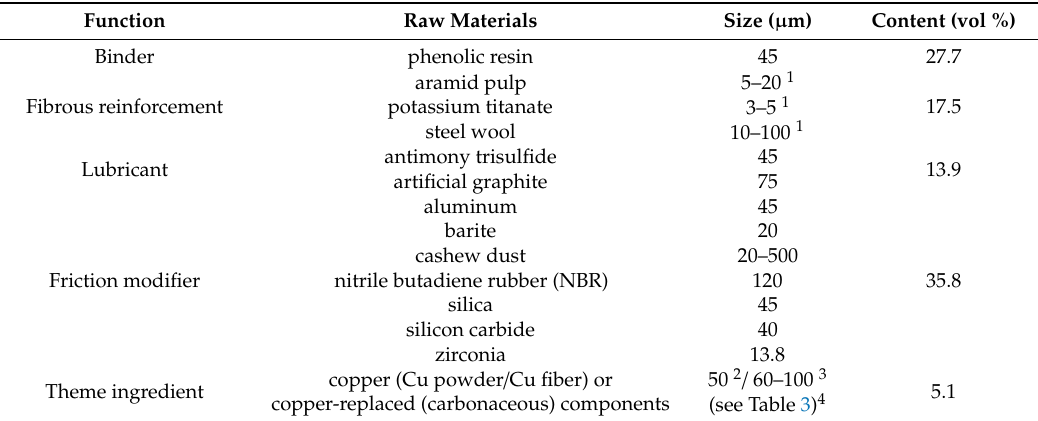
Table 1. Formulation of the friction materials.